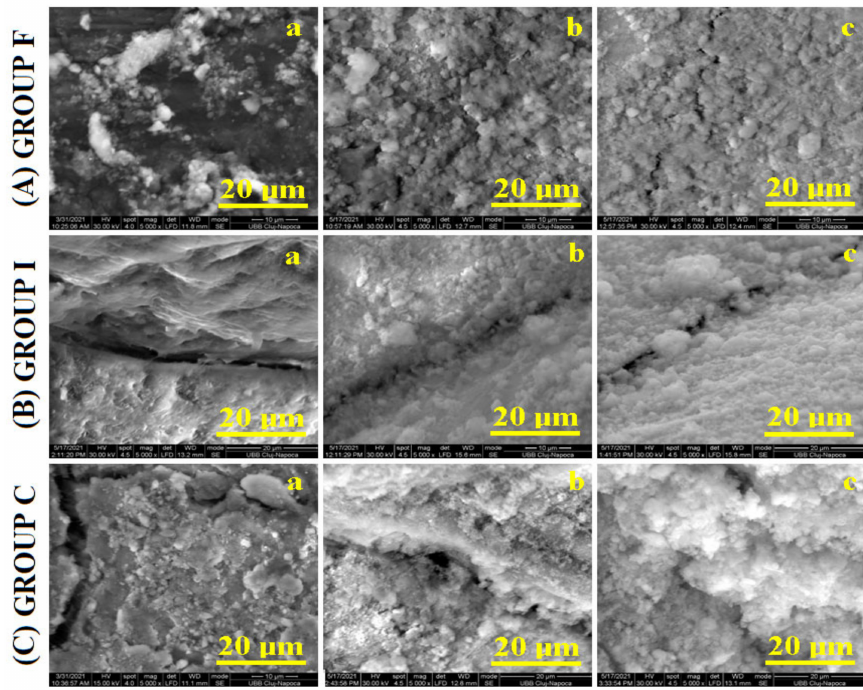
Figure 1. SEM images of the enamel samples: without treatment ( a ), after fluorination ( b ),and after photodynamic laser fluorination ( c ) for the investigated